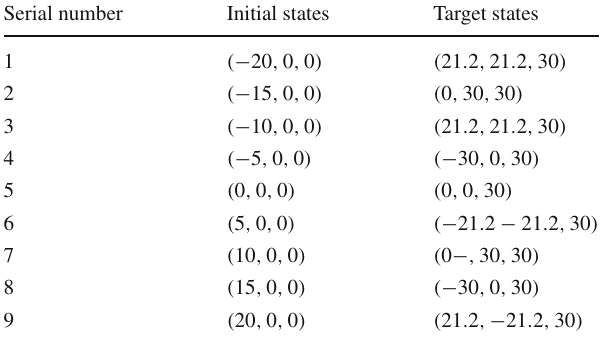
Table 10 States of UAVs’ group